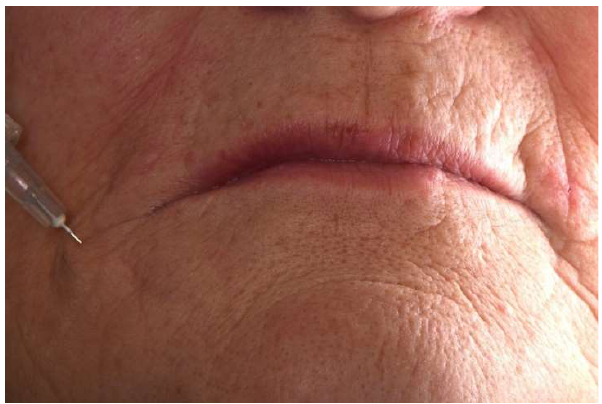
Figure 6. Injection of hyaluronic acid in front of the labial commissures.